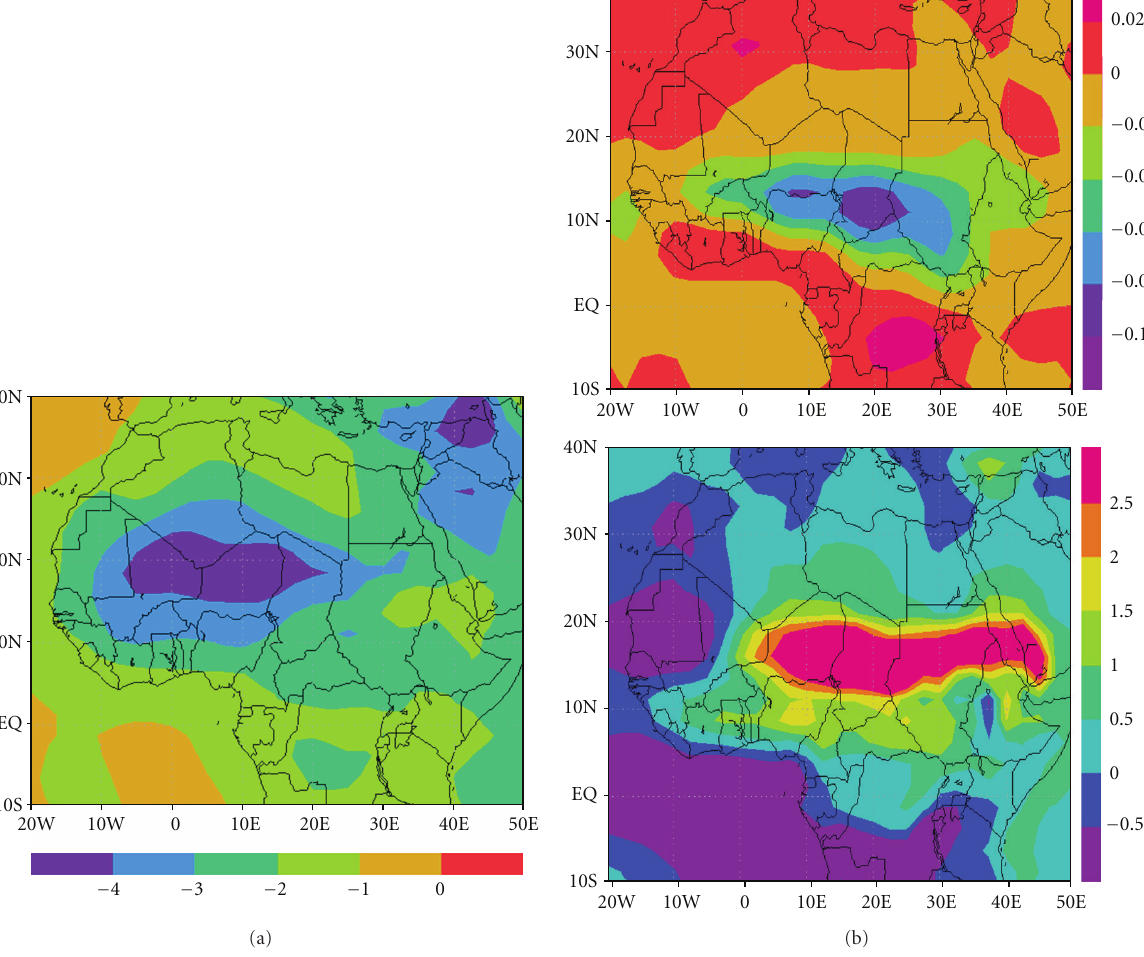
Figure 5: (a) Di ff erences of SLP composites in hPa. Average over 10 years with SAL lowest pressure minus average over 10 years with SAL highest pressure. (b) Di ff erences of SAL pressure composites at 850 hPa for ω in Pas − 1 (top), specific humidity in gkg − 1